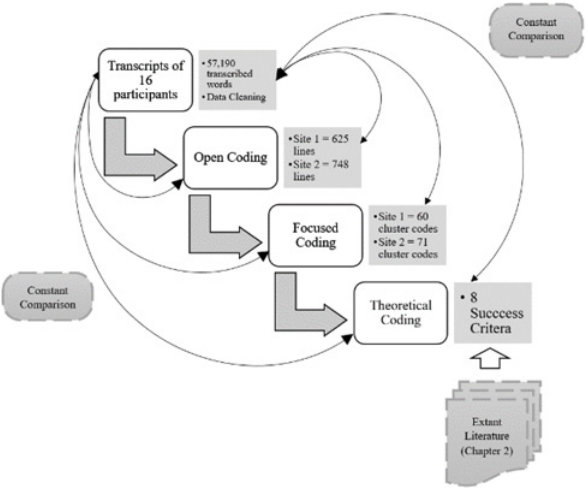
Figure 4 Coding Processes (Adapted from Charmaz (2014,